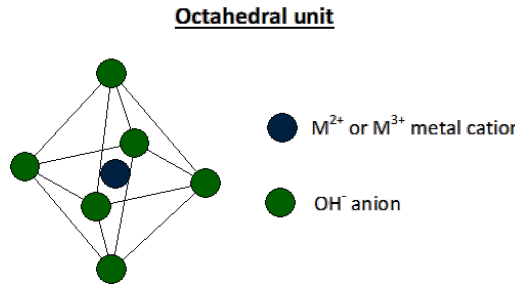
Figure 2. The octahedral unit of brucite-like layers in an hydrotalcite structure.